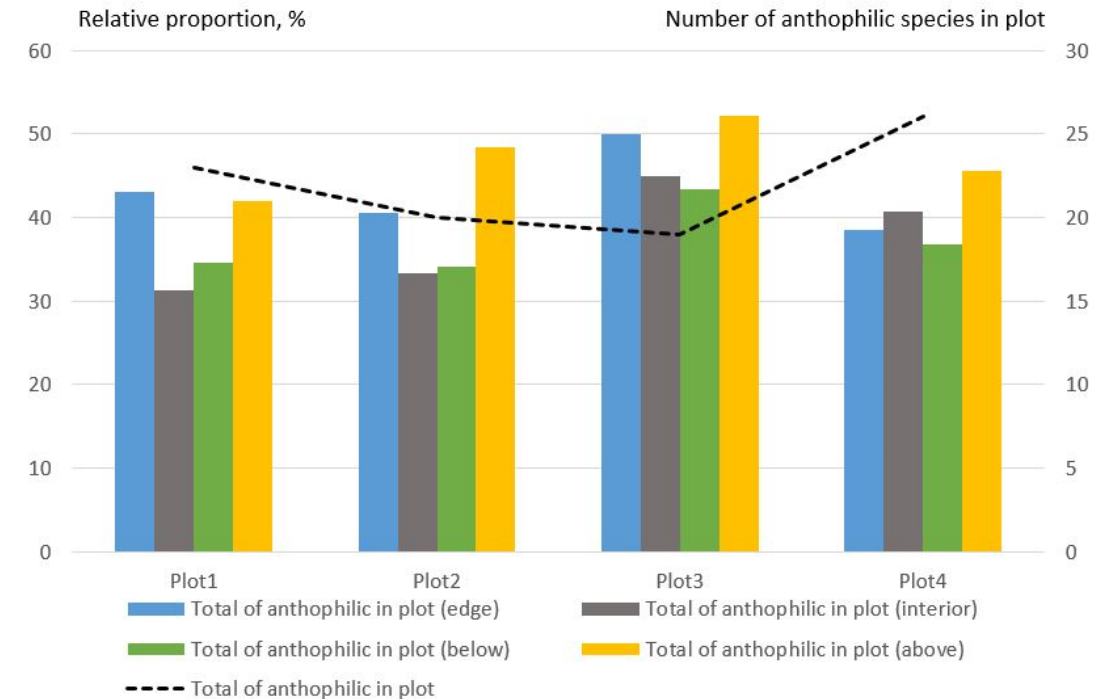
Figure 5. Relative proportion of anthophilic Coleoptera species collected using beer traps on the edges and in the forest interior (% of species per plot).